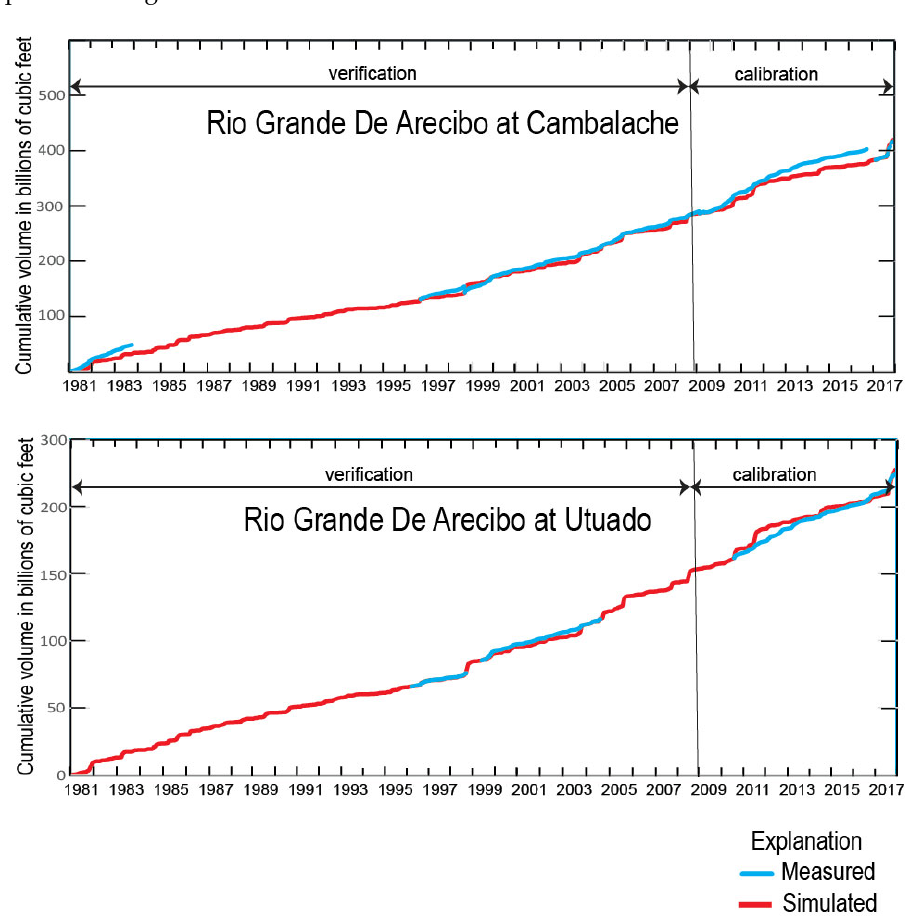
Figure 13. Cumulative daily flows at observation stations with Luca calibration of parameters. Horizontal lines show years used for validation and for calibration.